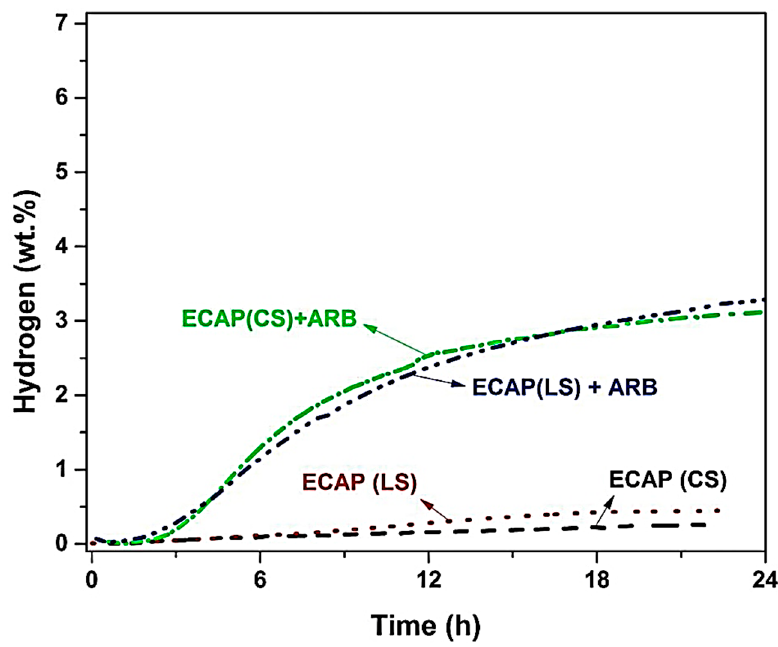
Figure 1. Kinetic curves of ZK60 without Mm. Reprinted with permission from Asselli A.A.C et al. (2015) Copyright 2015, Hydrogen Energy Publications.